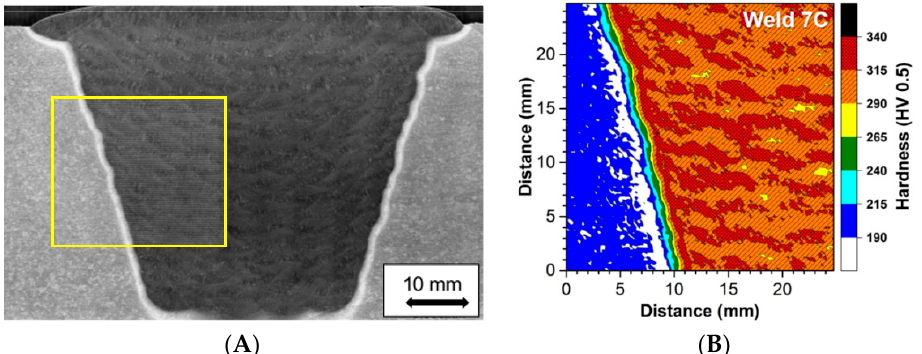
Figure 6. ( A ) Macro Sample of the As-fabricated Weldment in the Post Weld Heat Treated Condition (675 °C, 1250 °F for 2 h) with the yellow box showing the region examined by hardness mapping; ( B ) The hardness map produced with a scale showing hardness ranges for each colour.